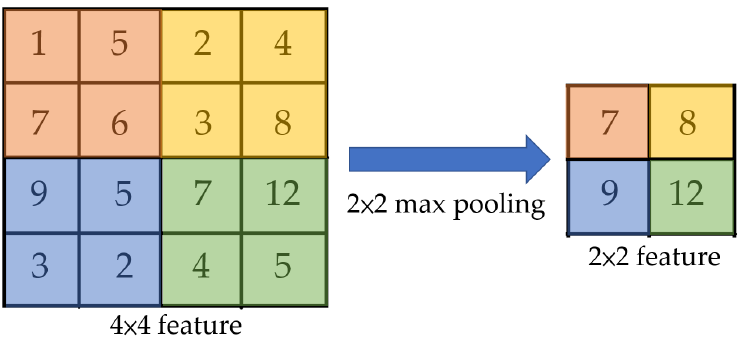
Figure 5. Operation of 2 × 2 max pooling on 4 × 4 feature.